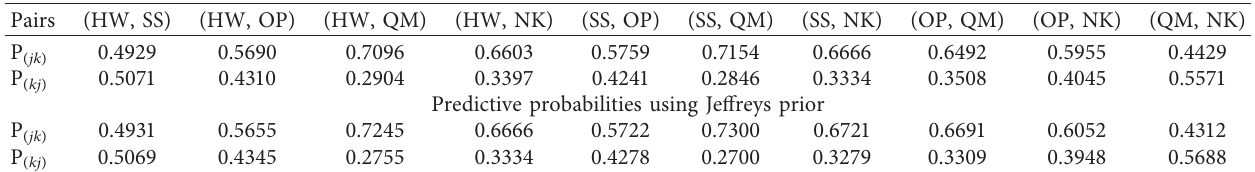
Table 5: Predictive probabilities using uniform prior.